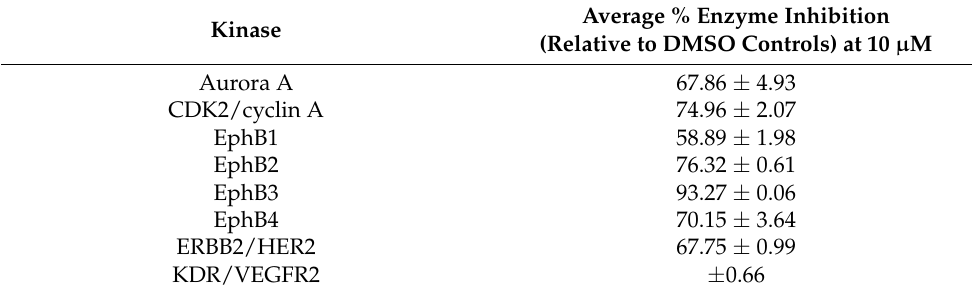
Table 6. % Inhibition values of compound 4c over a panel of different kinases.